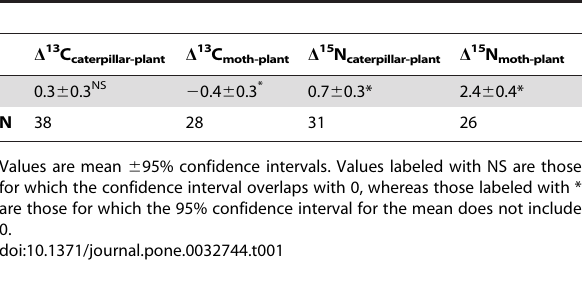
Table 1. Consumer to plant discrimination factors for caterpillars and moths of Trichoplusia ni fed on cabbage.